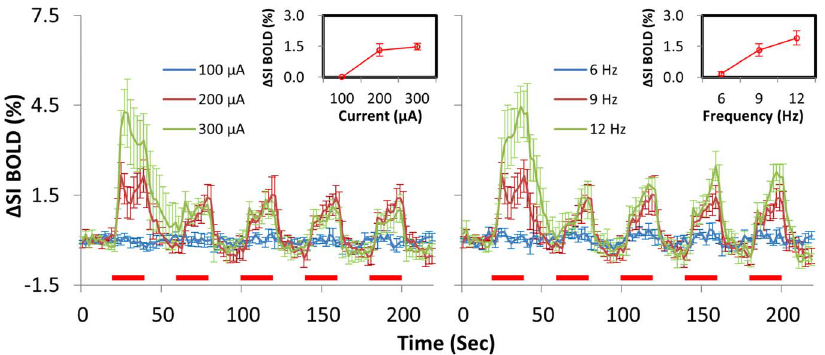
Figure 4. Amplitude and frequency dependency of BOLD response in dexmedetomidine-anesthetized rats. Averaged time courses within the S1 of 6 animals are plotted for 3 stimulus currents in the left panel, and 3 frequencies in the right panel. Red bars under the time courses indicate the 20-s stimulation period. The insets show the response amplitude versus the stimulus current or frequency. correlation coefficient of 0.82 (Fig. 6B, left panel, yellow data points, P , .05, n= 5) and 0.73 (Fig. 6B, left panel, red data points, P , .05, n =5) when using the stimulation parameters of 200 m A and 300 m A (9 Hz) respectively. The activated area sizes in both sessions also have strong consistency, with an intraclass correlation coefficient of 0.89 (Fig. 6B, right panel, yellow data points, P , .05, n =5) and 0.82 (Fig. 6B, right panel, red data points, P , .05, n= 5) when using the stimulation parameters of 200 m A and 300 m A (9 Hz) respectively. Overlap and size ratios between different stimulation parameters were similar. Size ratios ranged from 0.76